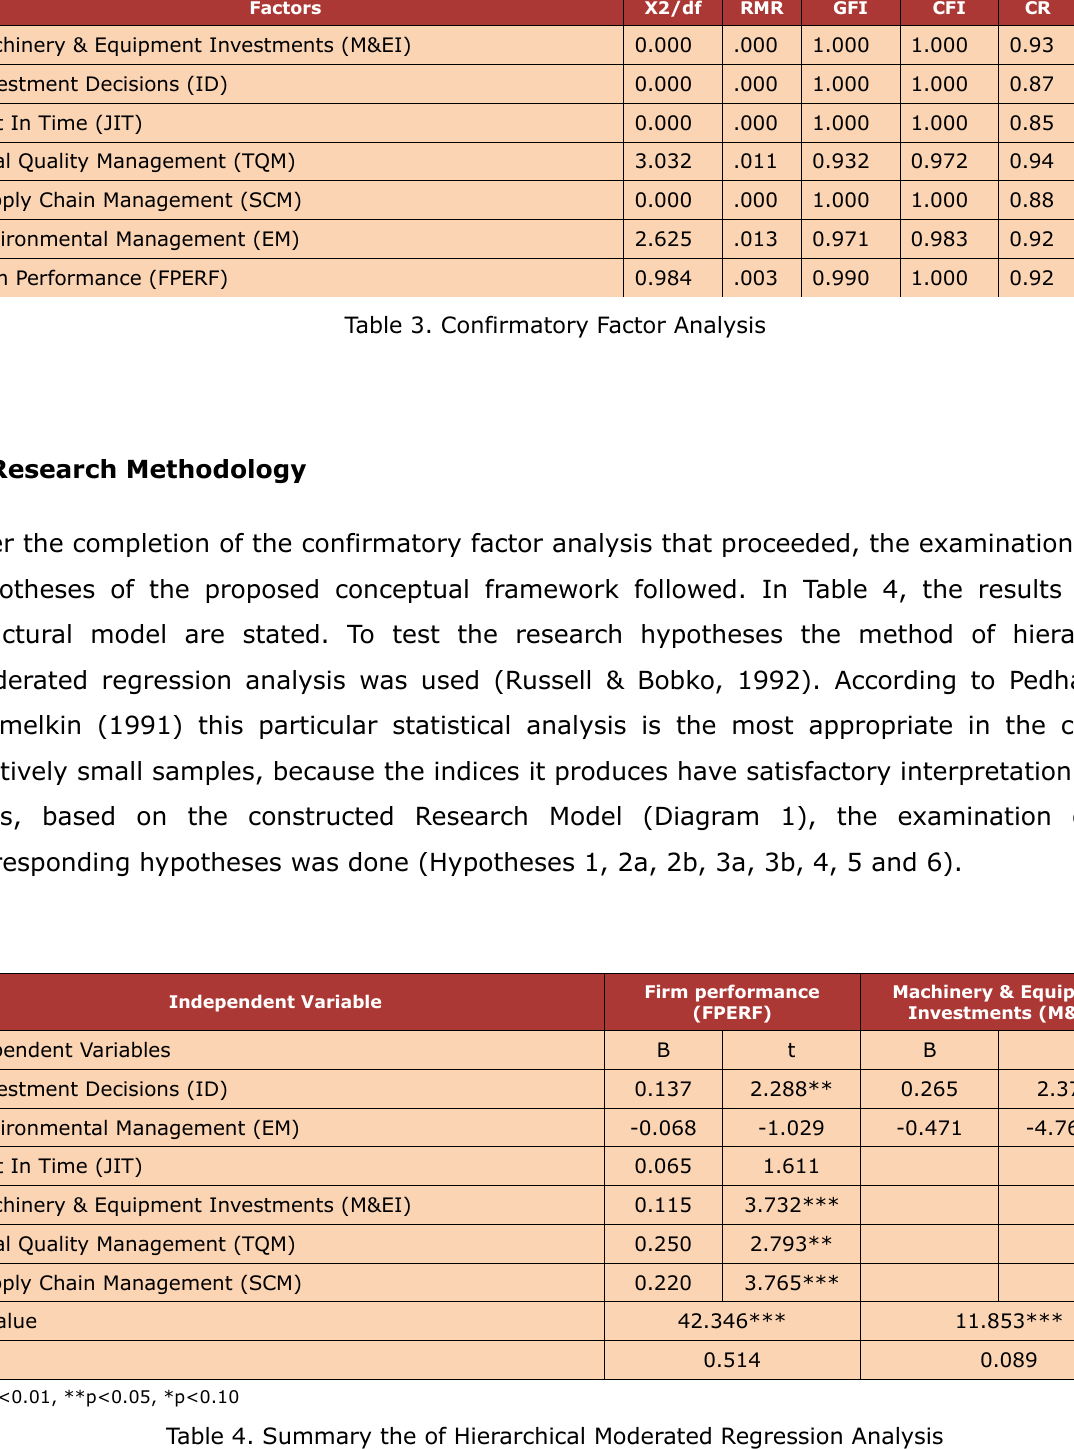
Table 4. Summary the of Hierarchical Moderated Regression